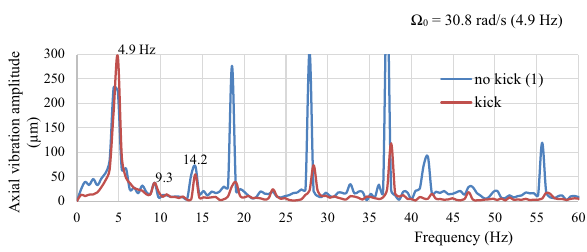
Fig. 24 Kick effects on axial bit–rock displacement (time domain)— Run_1 Fig. 25 Kick effects on axial bit–rock vibration